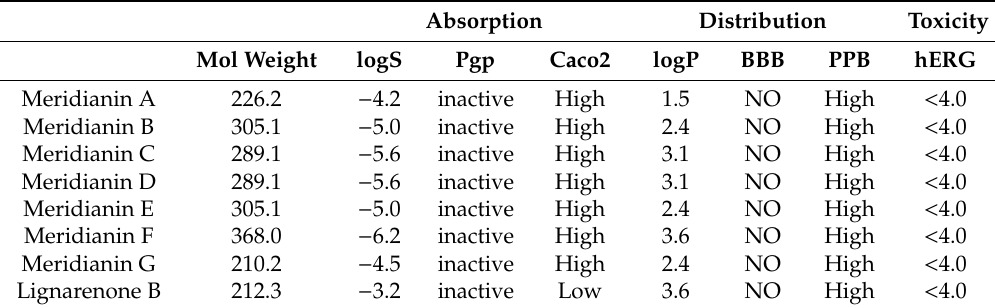
Table 2. Summary of absorption, distribution and toxicity properties of meridianins and lignarenone B. Pgp: P-Glycoprotein, BBB: blood-brain-barrier, PPB: plasma-protein binding, hERG: